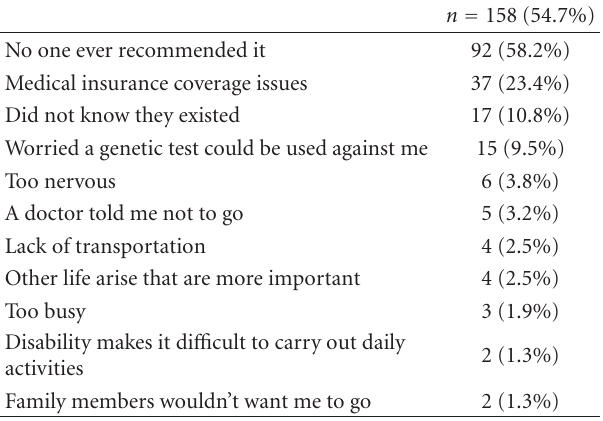
Table 5: Reasons for not having genetic counseling and risk assess- ment ∗ .